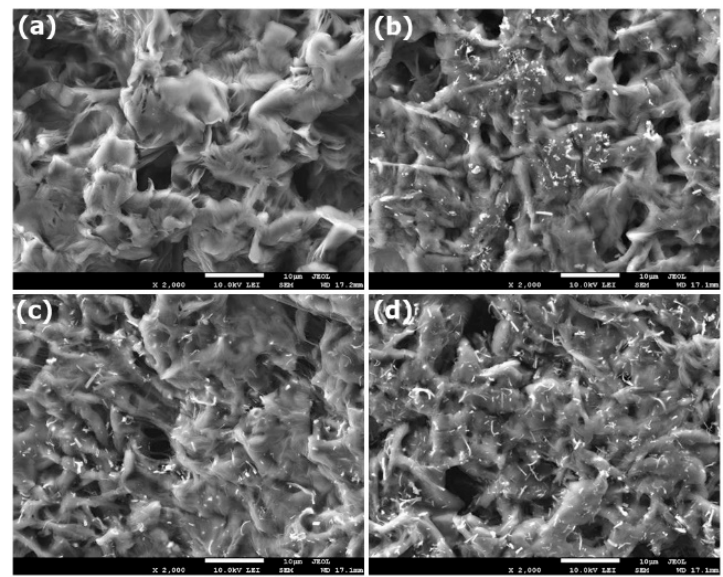
Figure 4. SEM images of ( a ) PCL, ( b ) PCL–SrHANF (65), ( c ) PCL–SrHANF (130), and ( d ) PCL–SrHANF (195). Scale bar = 10 µm.